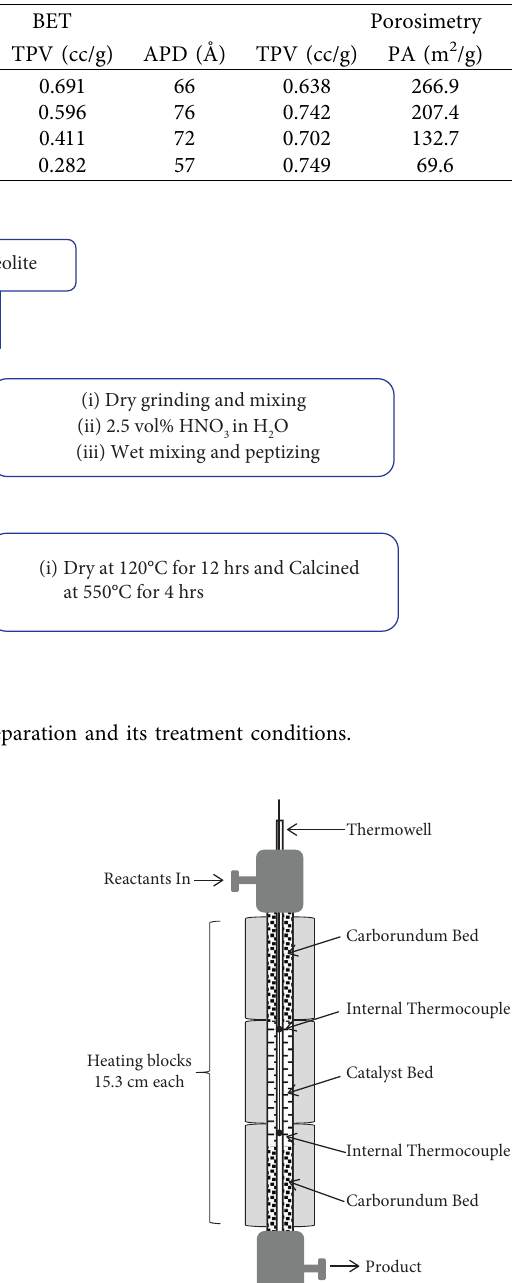
Table 1: Properties of prepared catalyst support.